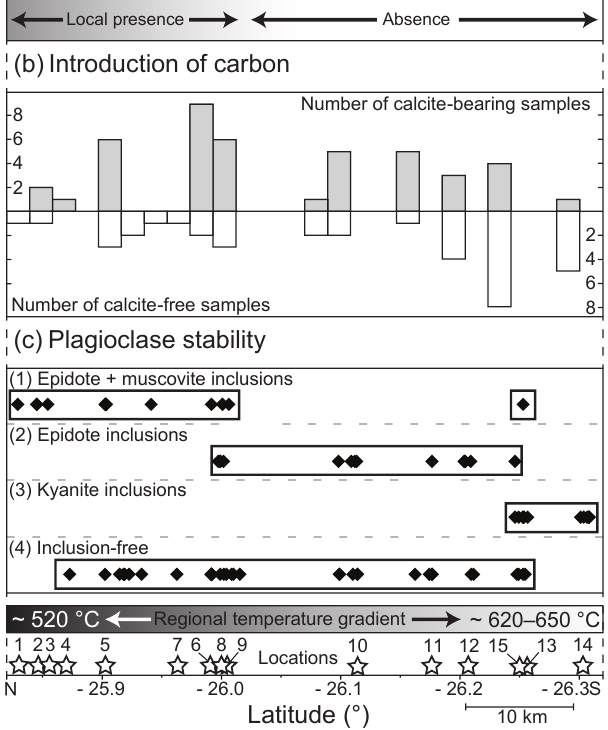
Figure 8. Regional variation in the development of (a) syntectonic quartz veins, (b) the introduction of carbon, and (c) plagioclase sta- bility and breakdown, each plotted against sample latitude. The re- gional temperature gradient (Wex et al., 2017) and the position of the studied locations (Fig. 1) are